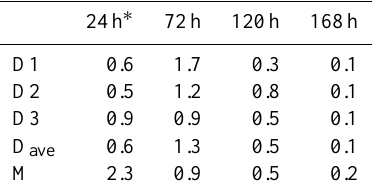
Table 6. Measured and modelled export flux of inorganic particles (gm − 2 d − 1 ) under dust addition, calculated assuming an Al con- tent of 4%. D1–D3 stand for the triplicate mesocosms with dust addition, D ave for the mean of D1–D3 and M for model results. Numbers are averaged fluxes in the time periods after dust addition. 24h ∗ 72h